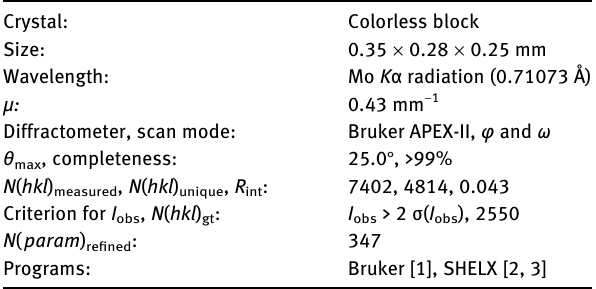
Table 2 contains the list of the atoms including atomic coordinates and displacement parameters.